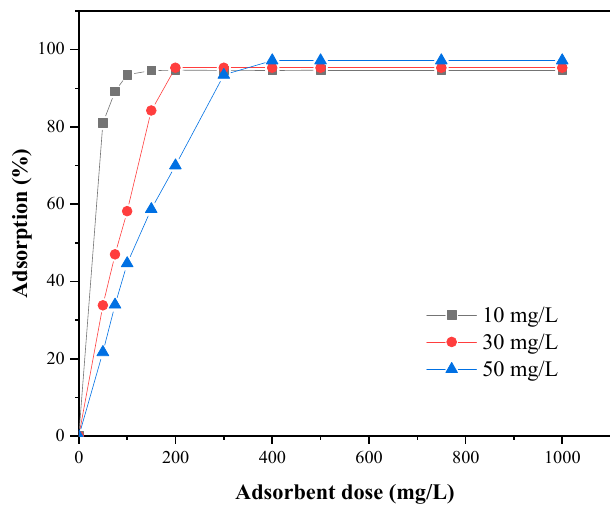
Figure 7. Effect of adsorbent dose on MB adsorption on SLS-C sample (contact time = 120 min).